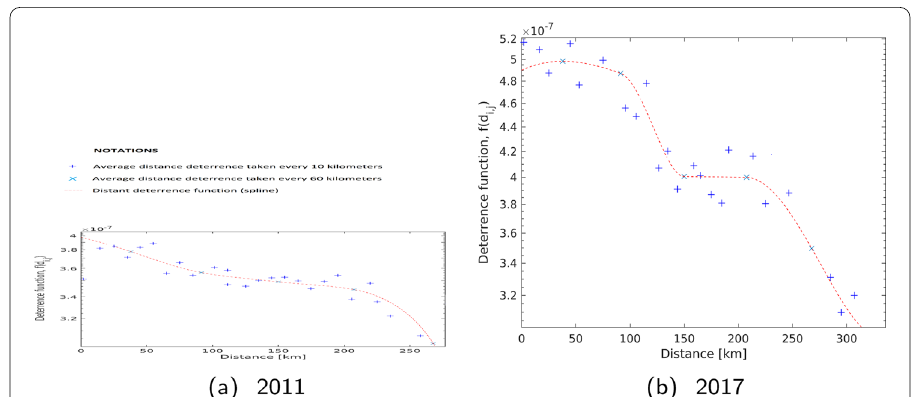
Fig. 9 Distance deterrence functions of applications (2011, 2017)